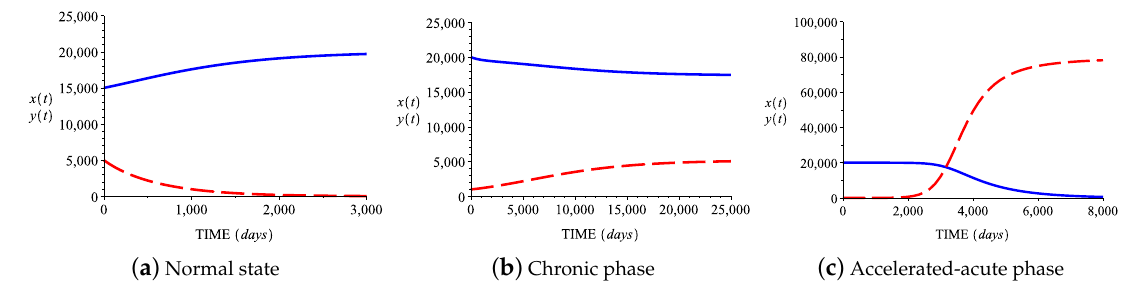
Figure 3. Behavior of the normal and abnormal (leukemic) stem cell populations in Case I. Initial conditions: ( a ) x ( 0 ) = 1.5 × 10 4 , y ( 0 ) = 5 × 10 3 ; ( b ) x ( 0 ) = 2 × 10 4 , y ( 0 ) = 1 × 10 3 ; ( c ) x ( 0 ) = 2 × 10 4 , y ( 0 ) = 1.